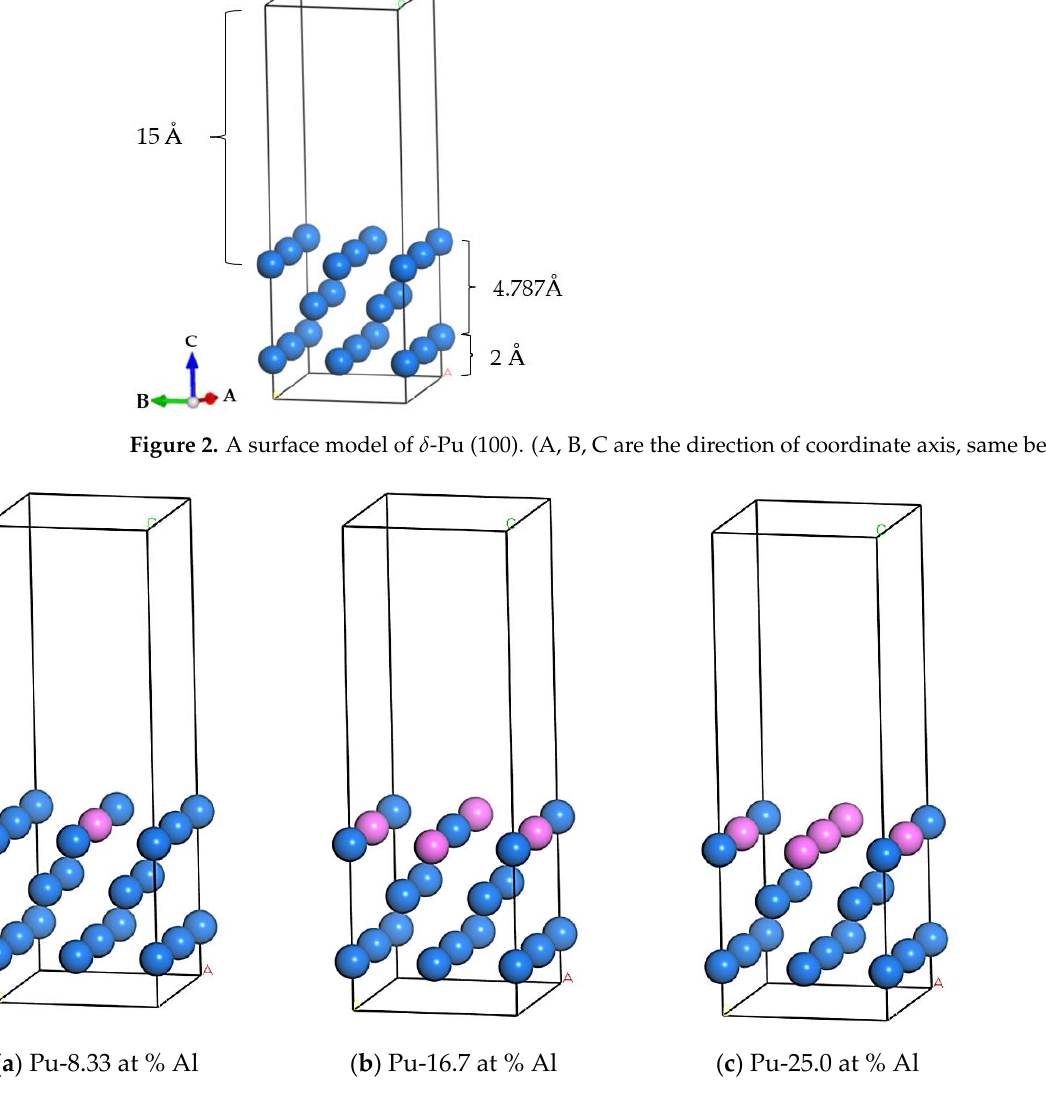
Figure 3. Pu-Al system model with different Al doping amounts. (The blue spheres represent plutonium atoms, and the pink spheres represent aluminum atoms).